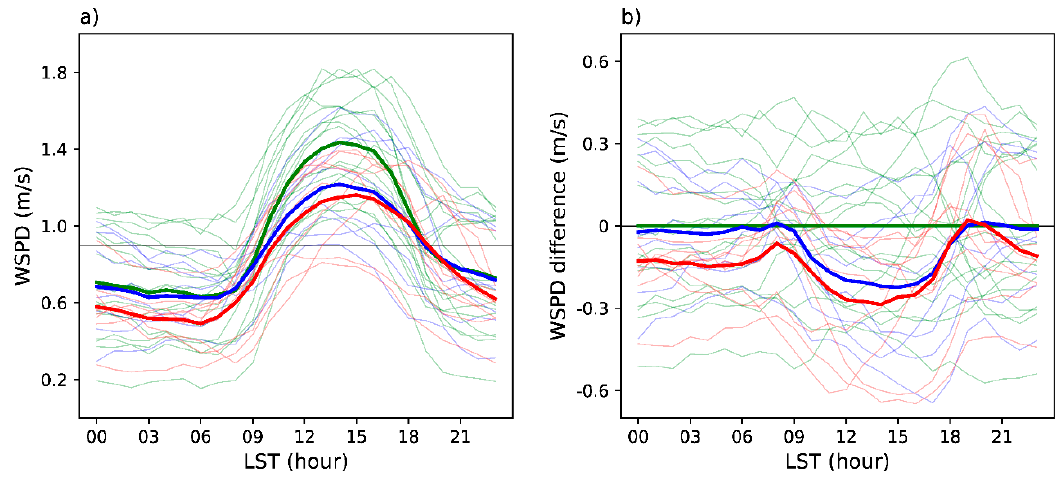
Figure 6. Same as Figure 3, but for mean diurnal cycle of ( a ) wind speed (m/s) and ( b ) wind speed difference (m/s; with respect to the average of rural sites).